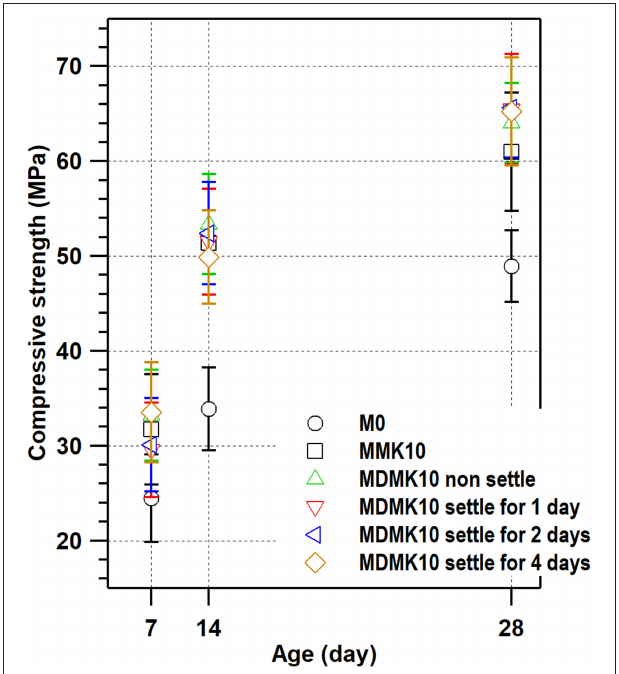
FIGURE 5 | Compressive strength of mortars with powder MK, pre-dispersed MK, and per-dispersed MK settled for 1, 2, and 4 days before addition.